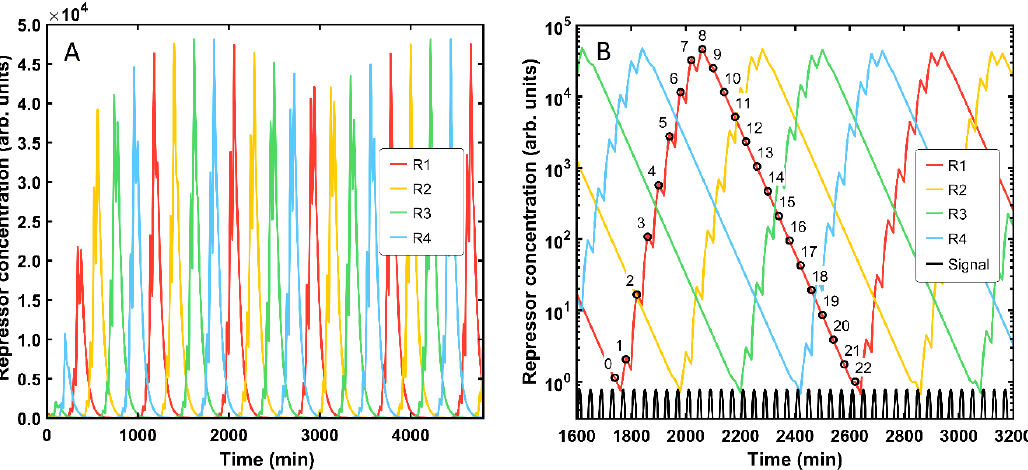
Figure 3. ( A ) Time evolution of the concentration of each repressor protein R n for the same parameter set in the base simulation except for k deg = 0.2 min − 1 and a much longer simulation period. ( B ) Same simulation as in ( A ), but the repressor-concentration axis is in logarithmic scale and the selected time scale is focused on one machine cycle. The input signal is depicted in black and its magnitude has been rescaled for clarity.